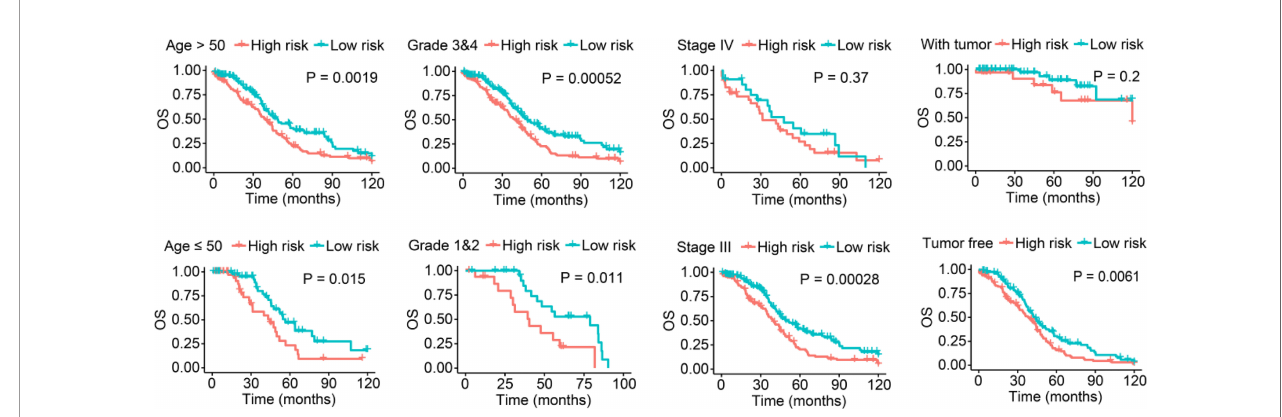
FIGURE 3 | Survival analysis strati fi ed by age, tumor grade, FIGO stage, and tumor status between the low- and high-risk groups in the entire set.